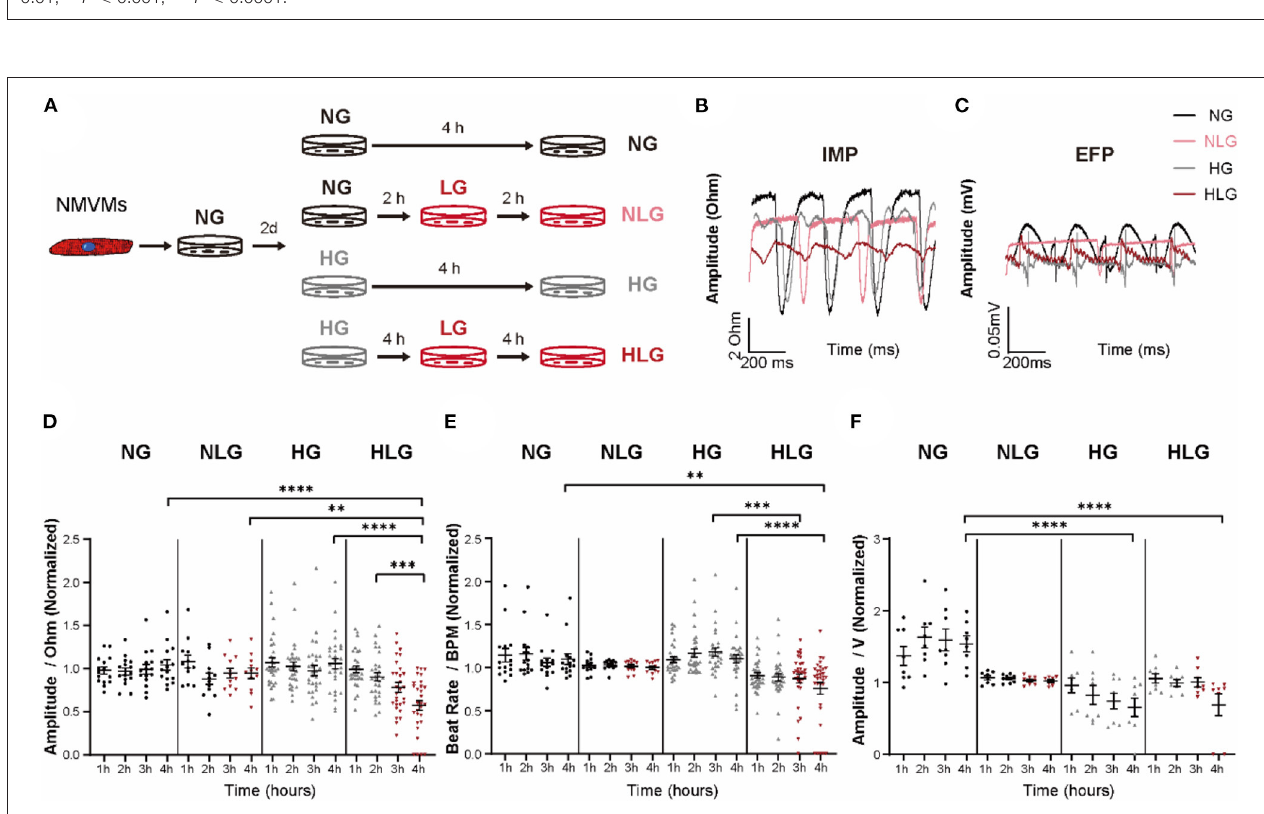
FIGURE 3 | Contractility and electrophysiology disorder in cardiomyocytes from high glucose following low glucose group (HLG)-treated neonatal mouse ventricular myocytes (NMVMs). (A) Culture conditions and treatments of NMVMs. (B,C) Impedance and extracellular field potential of NMVMs after 4h of pacing under different media conditions. (D–F) Analysis of impedance amplitude [ (D) , n = 15 wells for normal glucose group (NG), n = 12 wells for normal glucose following low glucose group (NLG), n = 30 wells for high glucose group (HG), and n = 29 wells for HLG], beat rate [ (E) , n = 15 wells for NG, n = 12 wells for NLG, n = 30 wells for HG, and n = 32 wells for HLG], and extracellular field potential [ (F) , n = 8 wells per condition] changes after 4h treatment. Data are shown as mean ± SEM. One-way ANOVA test was used. ** P < 0.01, *** P < 0.001, **** P <